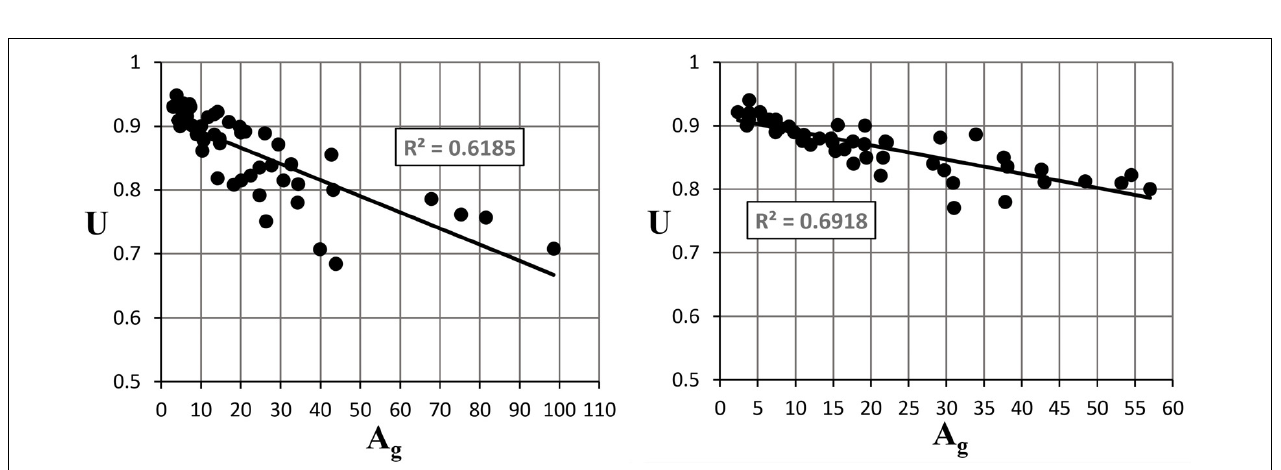
FIGURE 10 | U vs. A g based on FEA for W (left) and WT (right) sections (12 in. connection).